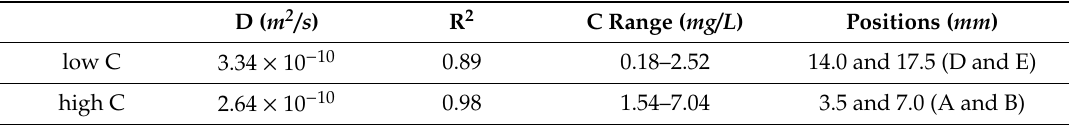
Table 4. Fitting result of inward di ff usion coe ffi cient at di ff erent C range with same data.